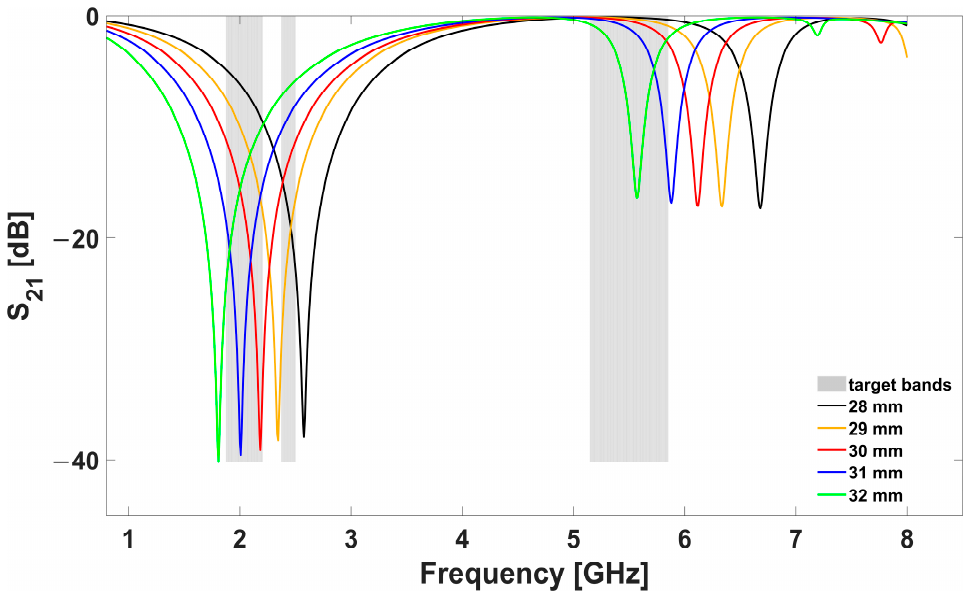
Figure 4. Simulated effect of increasing square length ( Lq sweep parameter).